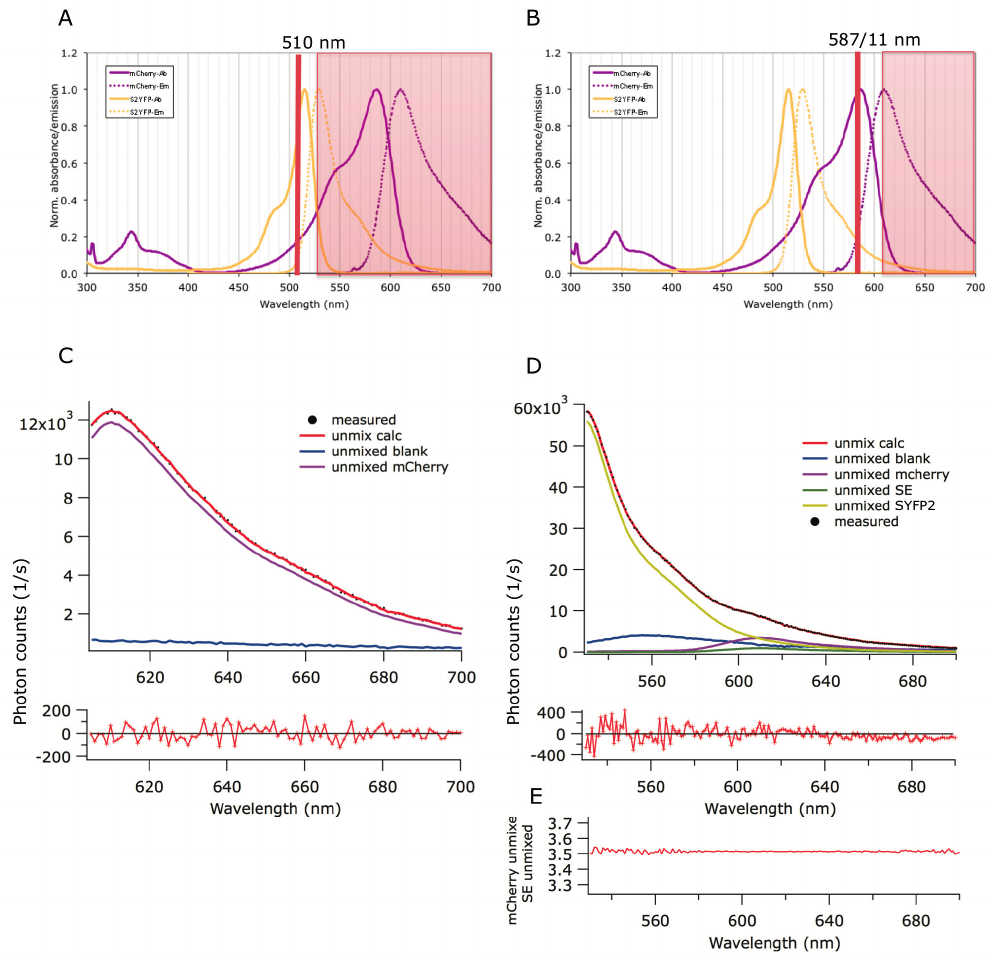
Figure 1. The principle of Förster Resonance Energy Transfer (FRET) analysis for the Super Yellow Fluorescent Protein 2 (SYFP2)-mCherry pair in cells measured in a cuvette. ( A ) SYFP2 and mCherry excitation at 510 nm; ( B ) SYFP2 and mCherry excitation at 587 nm; ( C ) The measured and unmixed mCherry acceptor spectrum; ( D ) The measured and unmixed SYPF2 and mCherry FRET pair sample spectra; ( E ) Ratio of the mCherry spectrum and the sensitized emission